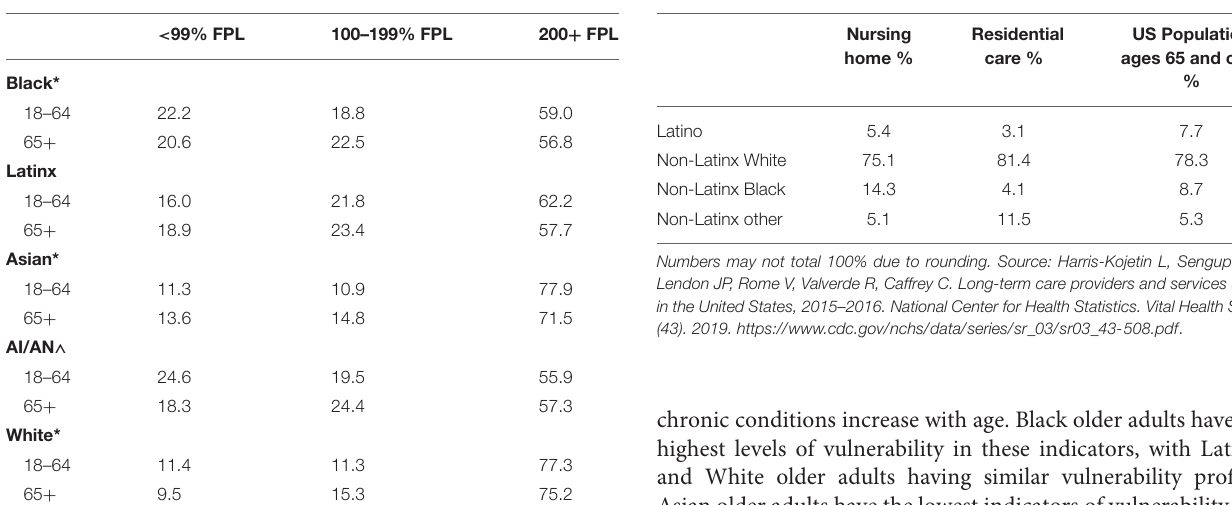
TABLE 1 | Poor and near poor older adults by race and ethnicity, US 2019. TABLE 2 | Long-term care use by race and ethnicity, US